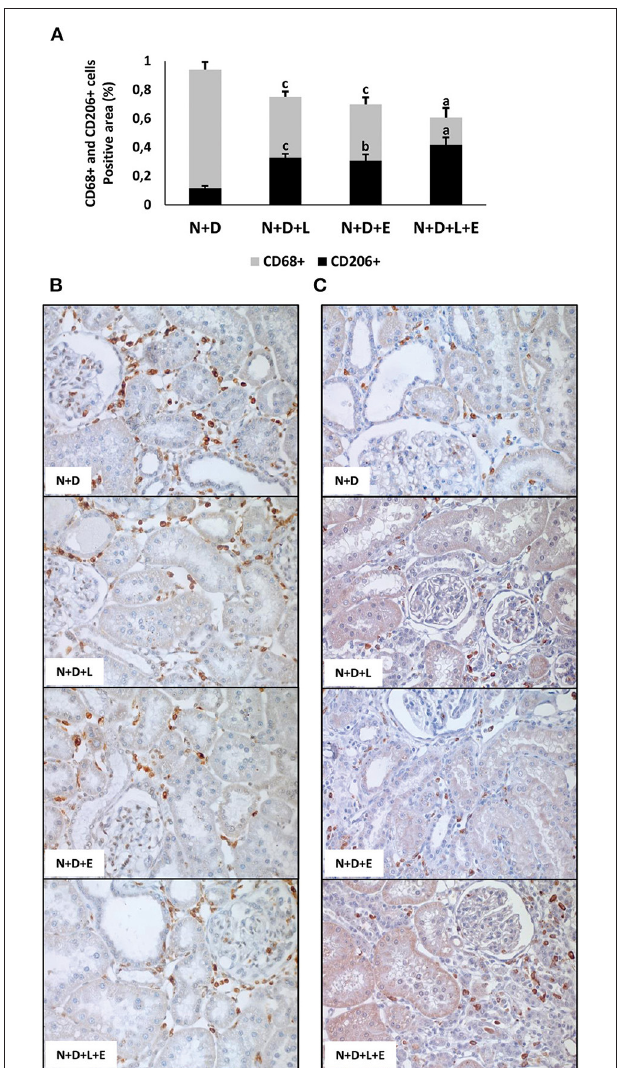
FIGURE 11 | Immunohistochemical analysis of CD68 + cells (M1 + M2 macrophages) and CD206 + cells (M2 macrophages) expression in the renal cortex evaluated 60 days after 5/6 nephrectomy in vitamin D-deficient rats treated with losartan, erlotinib or losartan + erlotinib. (A) Bar graph regarding the proportion of CD206 + cells in relation to the amount of CD68 + cells in N + D, N + D + L, N + D + E, and N + D + L + E groups. (B) Representative photomicrographs of immunostaining for CD68 + cells in the renal cortex from a N + D, N + D + L, N + D + E, and N + D + L + E rat (x400). (C) Representative photomicrographs of immunostaining for CD206 + cells in the renal cortex from a N + D, N + D + L, N + D + E, and N + D + L + E rat (x400). Note the higher expression of M2 macrophage subtype in the N + D + L, N + D + E, and N + D + L + E in comparison to the N + D. Data are mean ± SEM. a p < 0.001, b p < 0.01, c p < 0.05 vs. N + D. N, 5/6-nephrectomized rats; D, vitamin D-deficient rats; L, losartan-treated rats; E, erlotinib-treated rats; L + E, rats concomitantly treated with losartan + erlotinib. N + D ( n = 10); N + D + L ( n = 8); N + D + E ( n = 7); N + D + L + E ( n = 10).